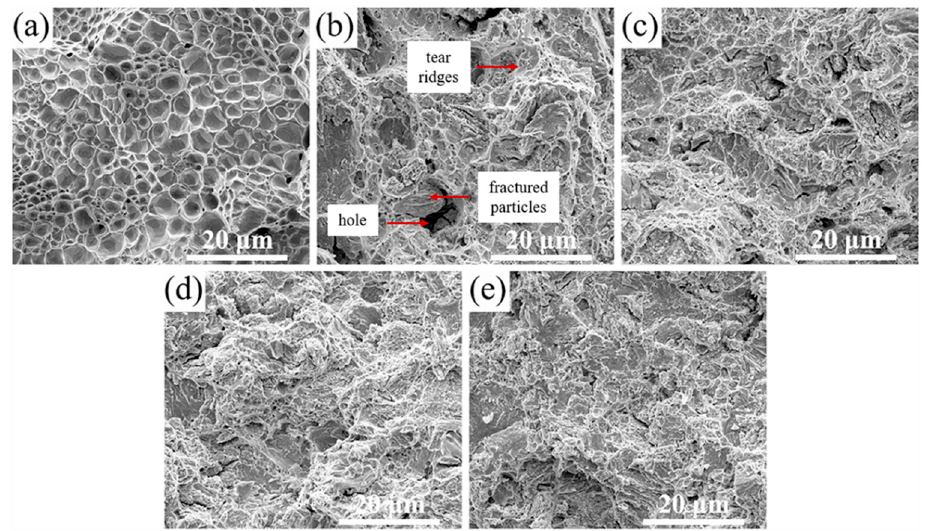
Figure 4. SEM images of fracture surface of ( a ) pure Cu sample and Cu composites with ( b ) 5 vol.% V 2 C, ( c ) 10 vol.% V 2 C, ( d ) 20 vol.% V 2 C, and ( e ) 30 vol.% V 2 C.